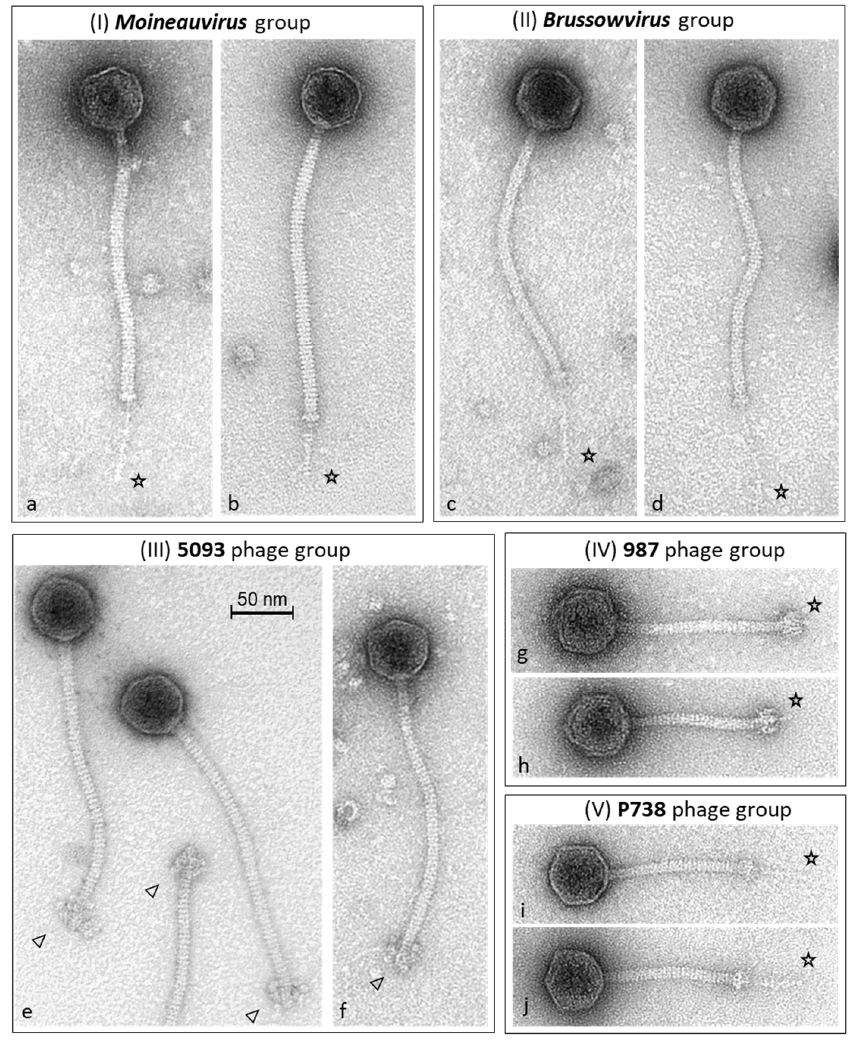
Figure 1. Transmission electron micrographs of negatively stained S. thermophilus phages representing the five phage groups ( I ) Moineauviruses (a. phage SW11 [16], b. phage STP1 [17]); ( II ) Brussowviruses (c. phage SW13 [16], d. phage CHPC1057 [18]); ( III ) 5093 phages (e. phage 5093 [11], f. phage SW27 [16]); ( IV ) 987 phages (g. phage 9871 [13], h. phage CHPC926 [18]); and ( V ) P738 phages (i. phage P738, j. phage D4446 [14]). The asterisks indicate the distal ends of the central tail fiber structures (of various lengths). The triangles show the globular appendages at the distal end of the 5093 phage tails. The (50 nm) scale bar is presented in panel e.